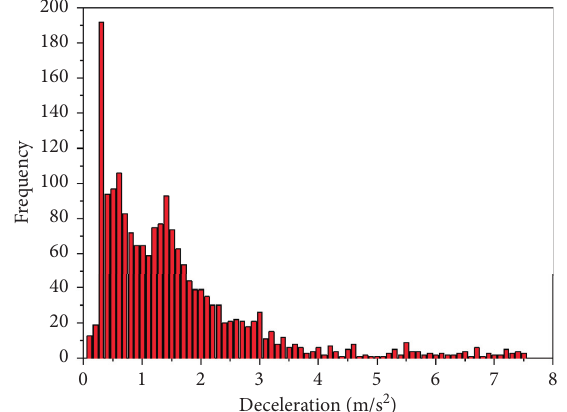
Figure 7: Deceleration frequency